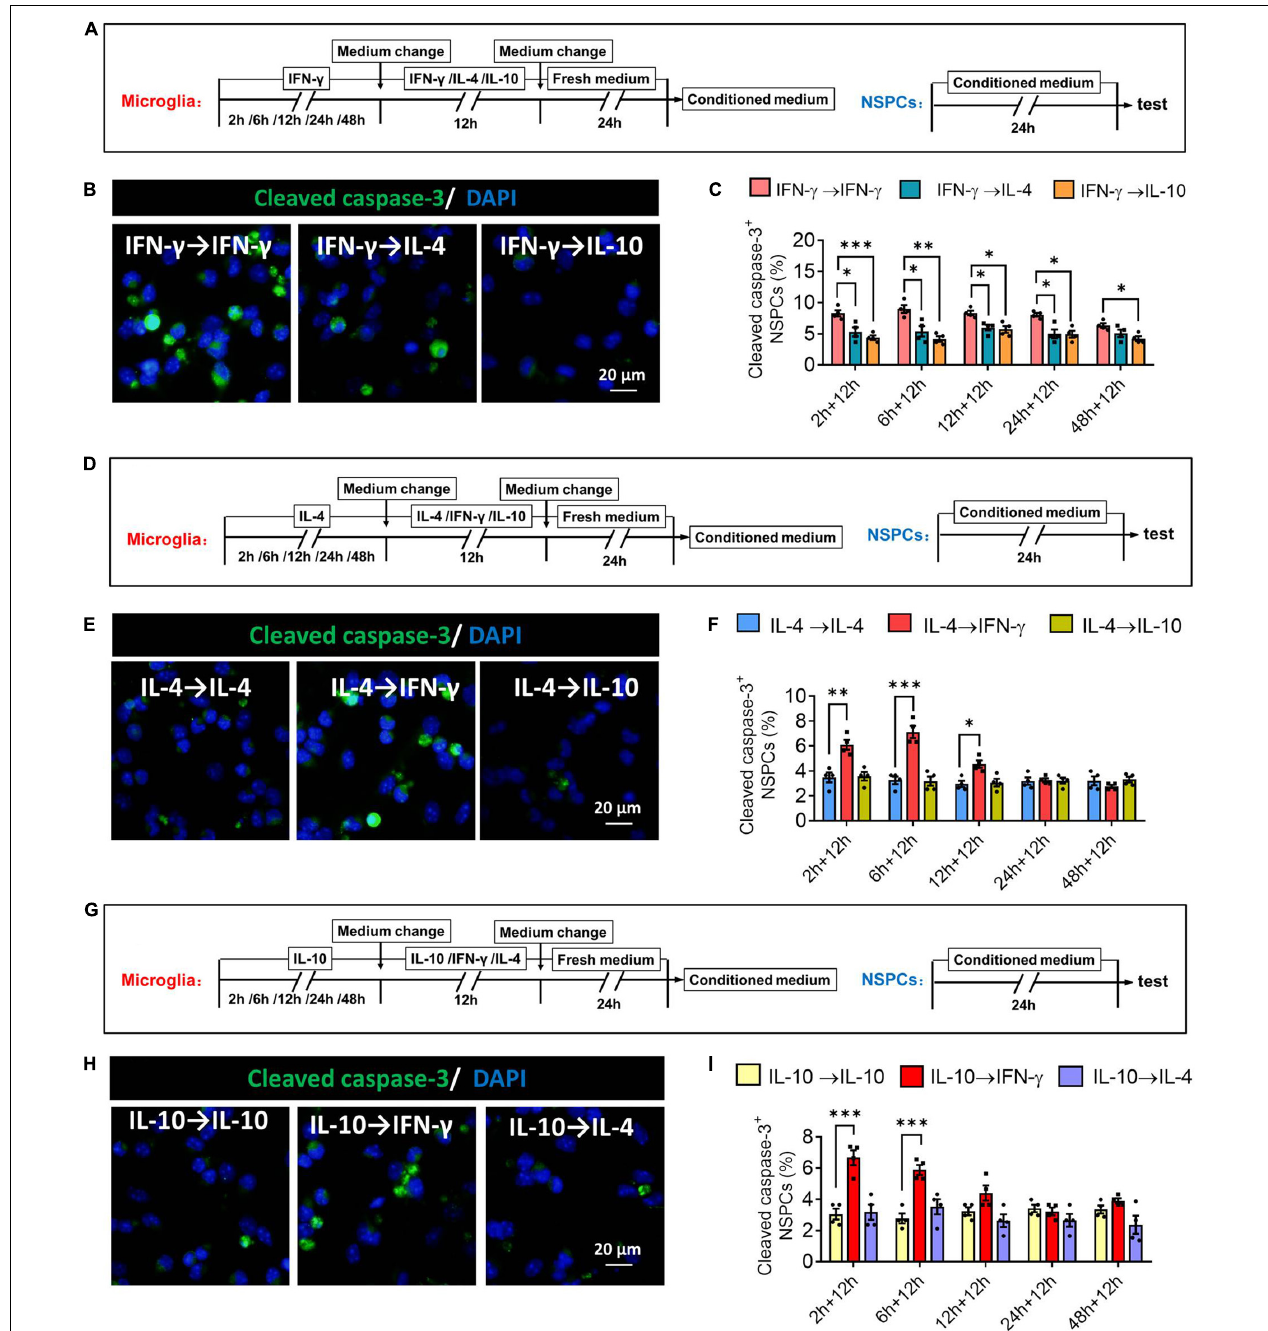
FIGURE 12 | Changes in neurotoxicity of IFN- γ , IL- 4-, or IL-10-treated microglia in different response state. (A–C) Changes in neurotoxicity of IFN- γ -treated microglia on NSPCs in different response state following IL-4 or IL-10 exposure for 12 h. (A) Experimental scheme to monitor neurotoxicity during activation. Microglia underwent stimulation with IFN- γ , IL-4, or IL-10 for 2–48 h, then the medium was changed and the cells were stimulated with another cytokine for 12 h. After then the cells were cultured with fresh medium for 24 h. The microglia-conditioned medium (M-CM) was collected and configured as a proliferation medium for neural stem/precursor cells (NSPCs). The NSPCs were cultured with M-CM for 24 h and the apoptotic NSPCs were detected. (B) Representative micrographs showing immunocytochemical labeling for cleaved caspase-3 in NSPCs treated for 24 h with conditioned medium from the reprogrammed microglia. (C) Quantification of the percentages of cleaved caspase-3 + -DAPI + cells following treatment with conditioned medium from the reprogrammed microglia. (D–F) Changes in neurotoxicity of IL-4-treated microglia on NSPCs in different response state following IFN- γ or IL-10 exposure for 12 h. (G–I) Changes in neurotoxicity of IL-10-treated microglia on NSPCs in different response state following IFN- γ or IL-10 exposure for 12 h. Five 40 × photographs were taken from each well, and all the cells in the field were measured. Data are presented as the mean ± SEM. n = 4–5 well per group, ∗ P < 0.05, ∗∗ P < 0.01, ∗∗∗ P < 0.005 (one-way ANOVA with Tukey’s multiple-comparisons